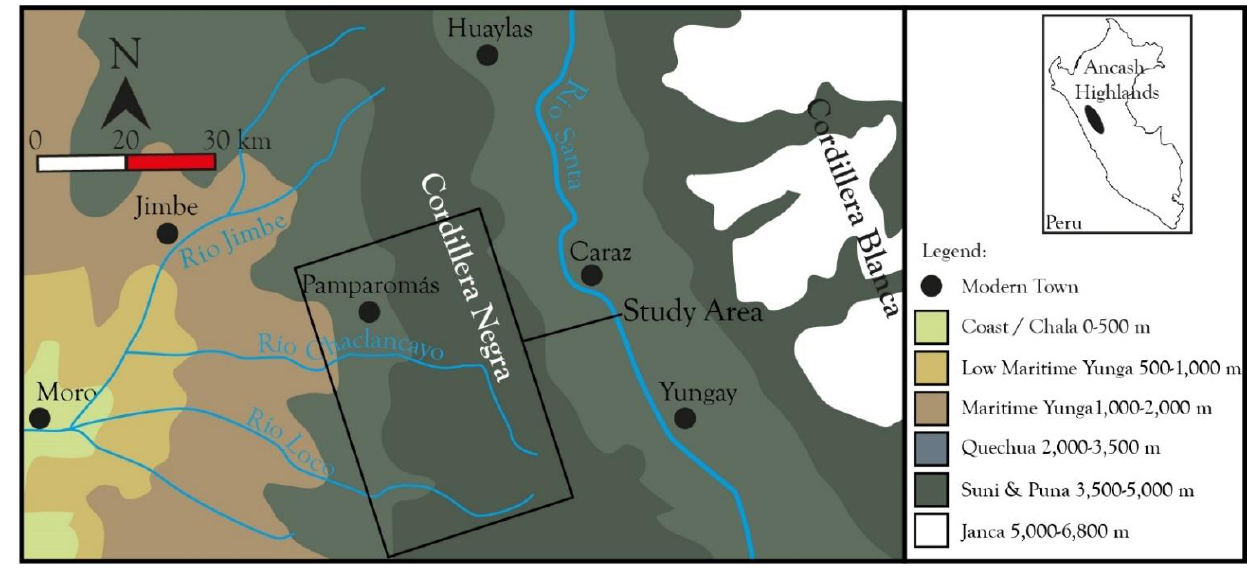
Figure 1. Map of the study area.